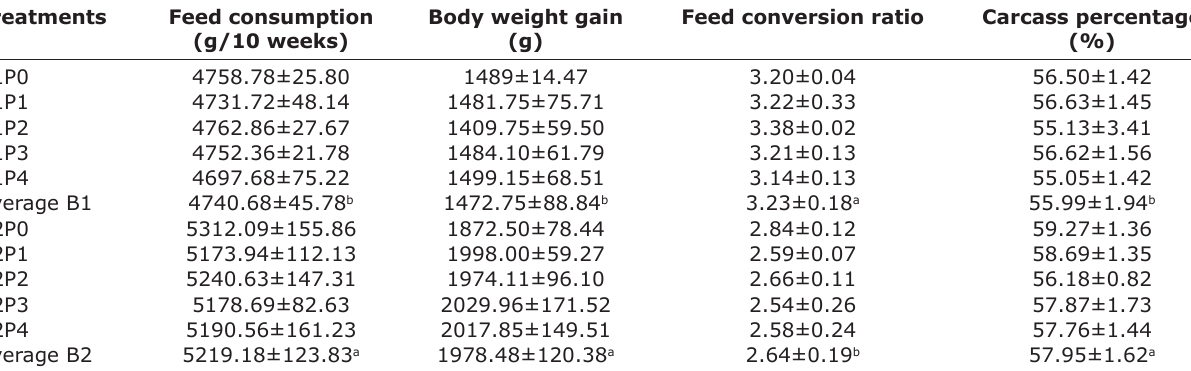
Table-6: Effect of interaction between breeds and phytogenics supplement on feed consumption, body weight, feed conversion ratio, and carcass percentage.